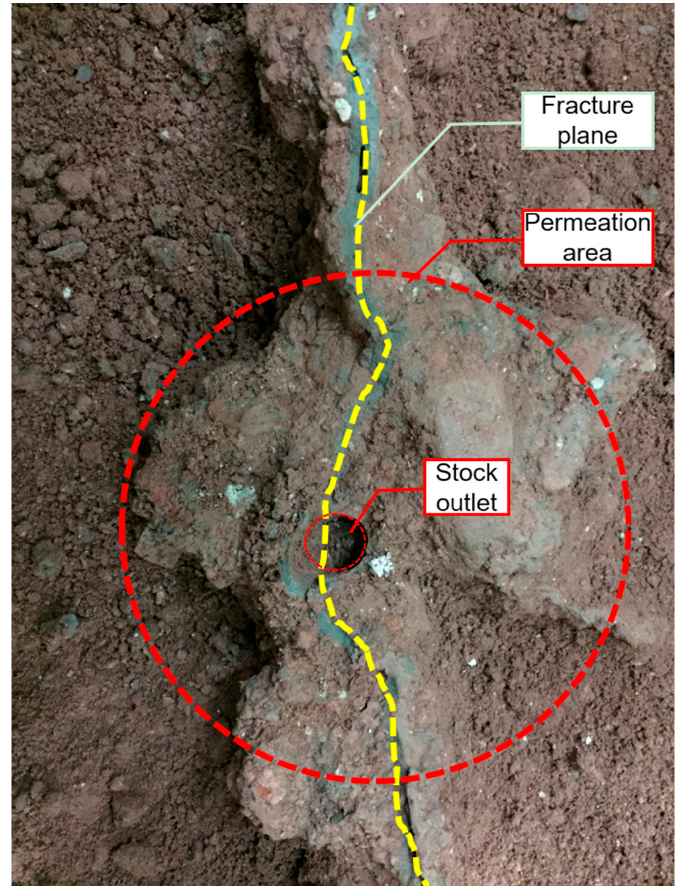
Figure 14. Concretion section of Group #3.